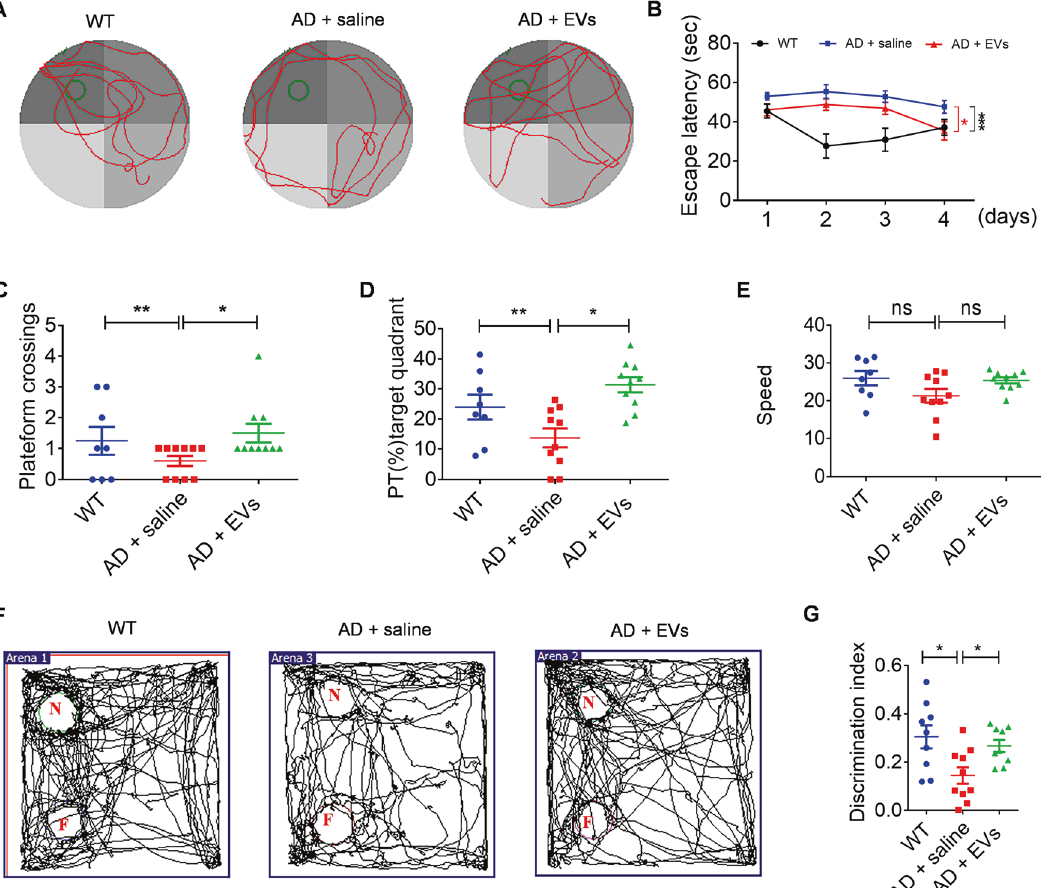
Fig. 3 MSC-EVs treatment improves cognitive de fi cits in the APP/PS1 mice. A The trajectory of three groups mice in Morris Water Maze (MWM) test. B After MSC-EVs administration for 1 month, statistical analysis presents the spatial learning session and escape latency in the experimental groups. C – E In the probe test, histogram show the platform crossings ( C ), percentage of the total time (PT %)-target quadrant ( D ), and speed (mm / second) ( E ) in different experimental groups. F Motion trail of each group in novel object recognition test (NORT) (N novel object, F familiar object). G Comparison of the discrimination index of WT ( n = 8), AD + saline ( n = 10), and AD + EVs ( n = 10) groups mice. The values represent Mean ± SEM. The data meet normal distribution and the variance is homogeneous. * P < 0.05, ** P < 0.01, ns P >